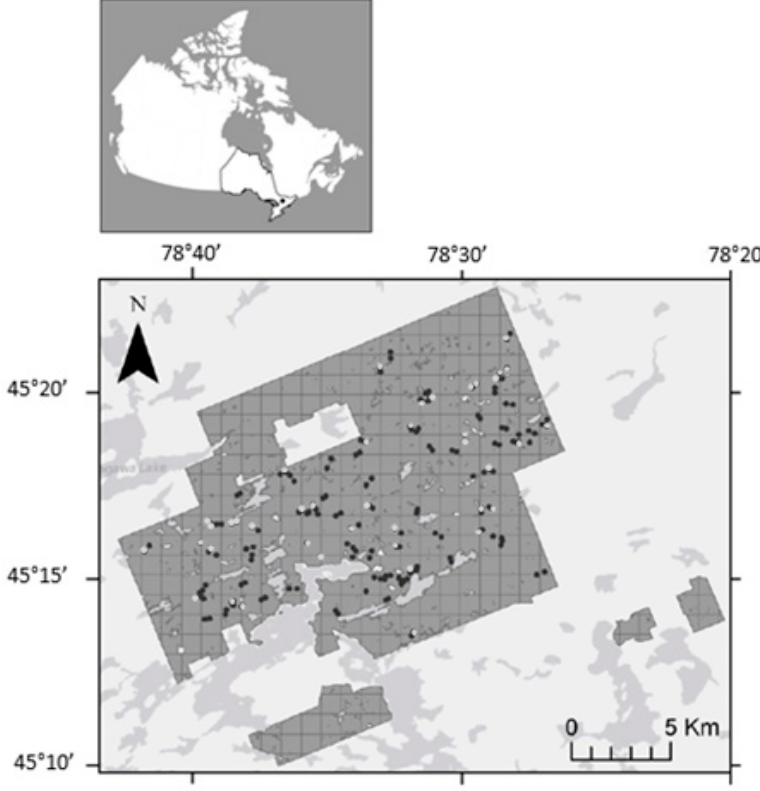
Figure 1. Locations of 154 calibration and validation ground plots in Haliburton Forest and Wildlife Reserve in Ontario, Canada. Black dots represent calibration plots and light grey dots represent validation plots.